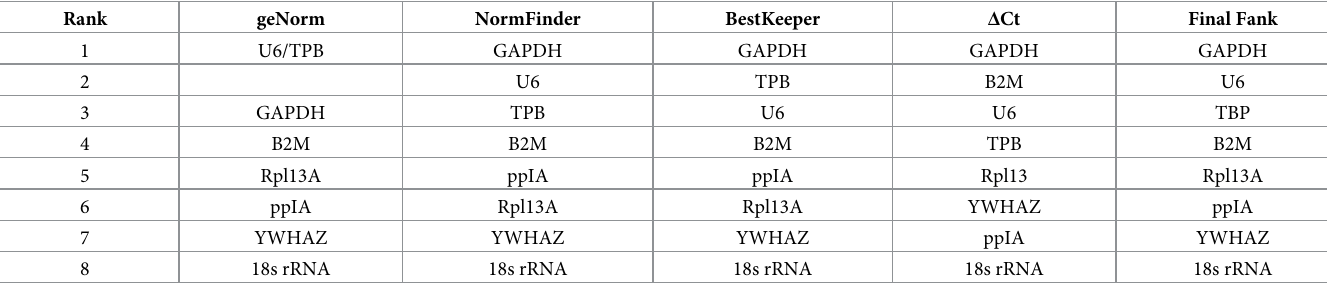
Table 3. Final rankings of candidate reference